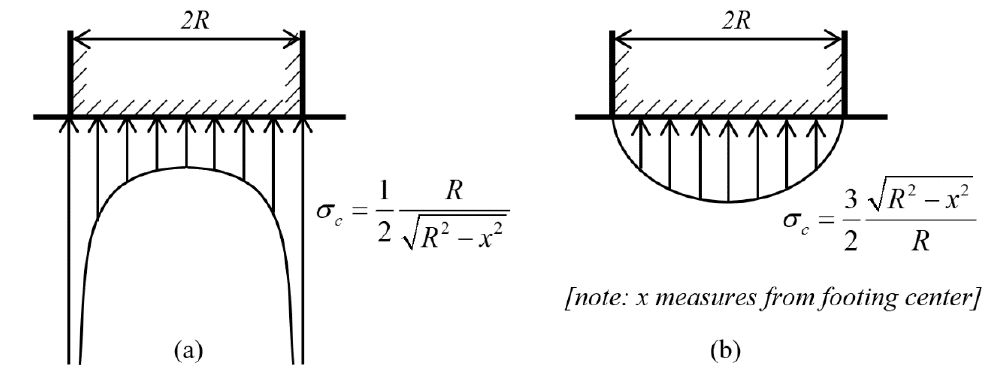
Figure 8. Assumed contact pressure distribution for the case of rigid circular footing on ( a ) clay and ( b ) sand.